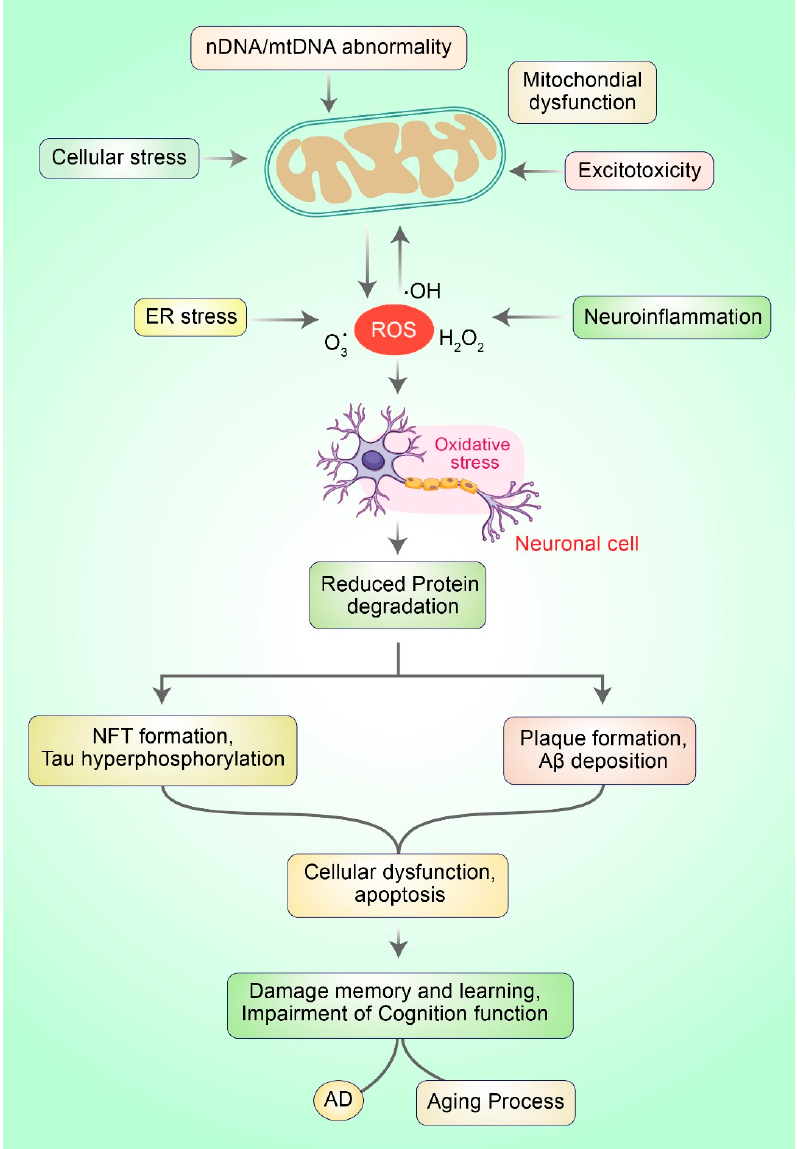
Figure 1. Mitochondrial dysfunction and oxidative stress in neurons lead to the development of AD. Typically, ROS are produced via numerous mechanisms such as ER stress, mitochondrial dysfunction, neuroinflammation, and excitotoxicity. Excessive ROS generation leads to oxi-dative stress (OS), which is responsible for mitochondrial dysfunction. OS prevents the deg-radation of protein molecules and impairs the clearance of misfolded proteins, which subse-quently leads to protein aggregation causing neuronal death and